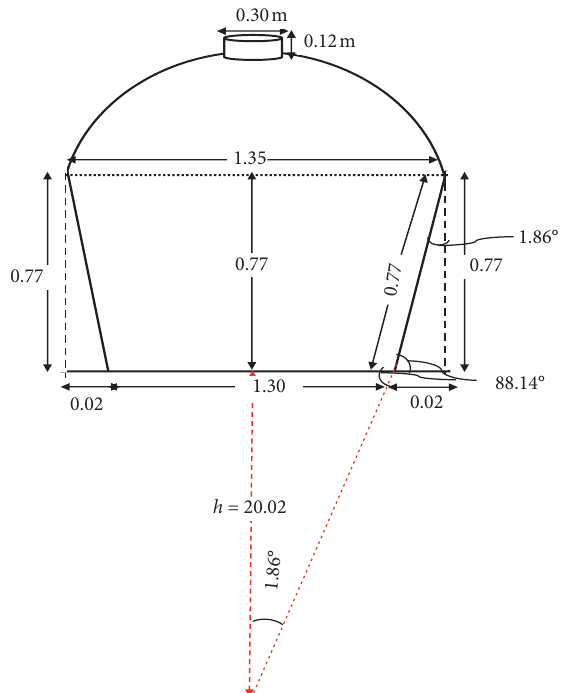
Figure 3: The design calculation of the volume of the biogas di- gester (all measurements are in